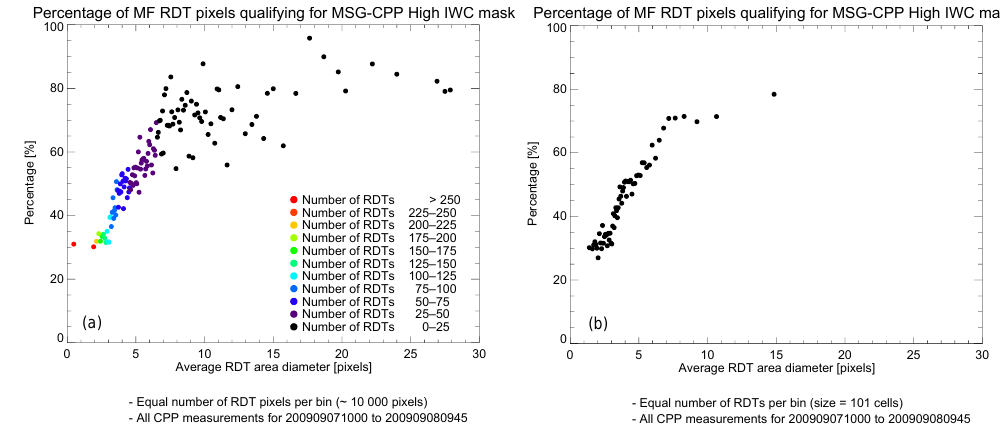
Figure 6. Correlation between average RDT area (square root of number of pixels with RDT cell) and fraction of pixels per cell identified by the high IWC mask for AIRBUS event 24. For the left plot each dot represents approximately of 10000 RDT pixels; for the right plot each dot represents an equal number of RDT cells (total number of RDT cells for day of event 24 is 12416). The color coding in the left plot indicates the number of RDT cells for each dot. The figure represents one 24h period of RDT and MSG-CPP measurements on 7 and 8 September